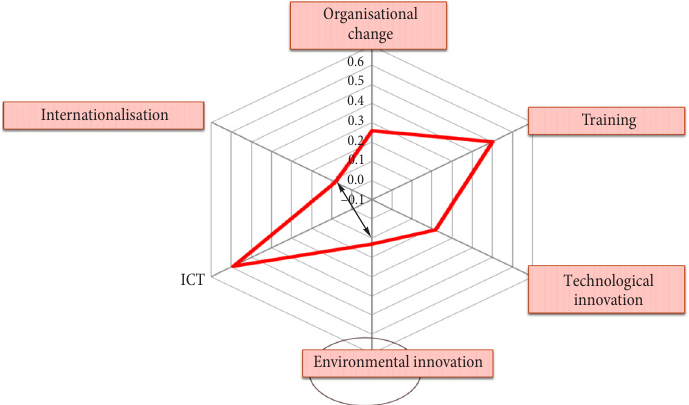
Fig. A2. The Innovation set of